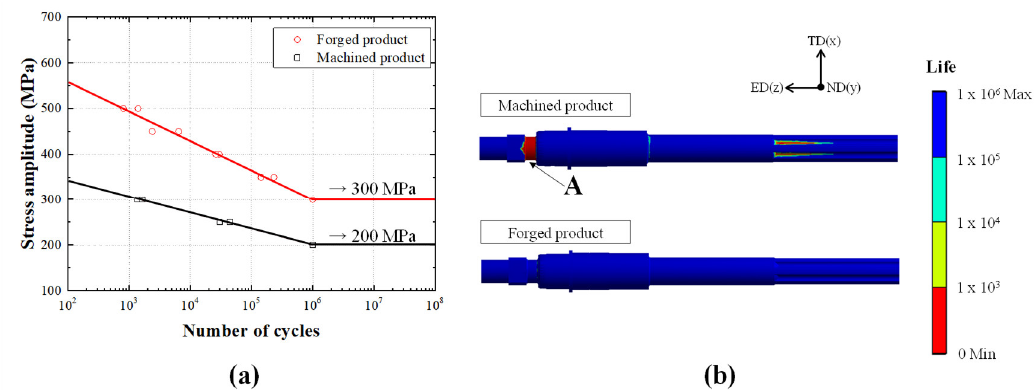
Figure 11. ( a ) Comparison of the machined and forged products based on their Stress amplitude–Number of cycles curve obtained via the fatigue test and ( b ) results of the fatigue analysis.